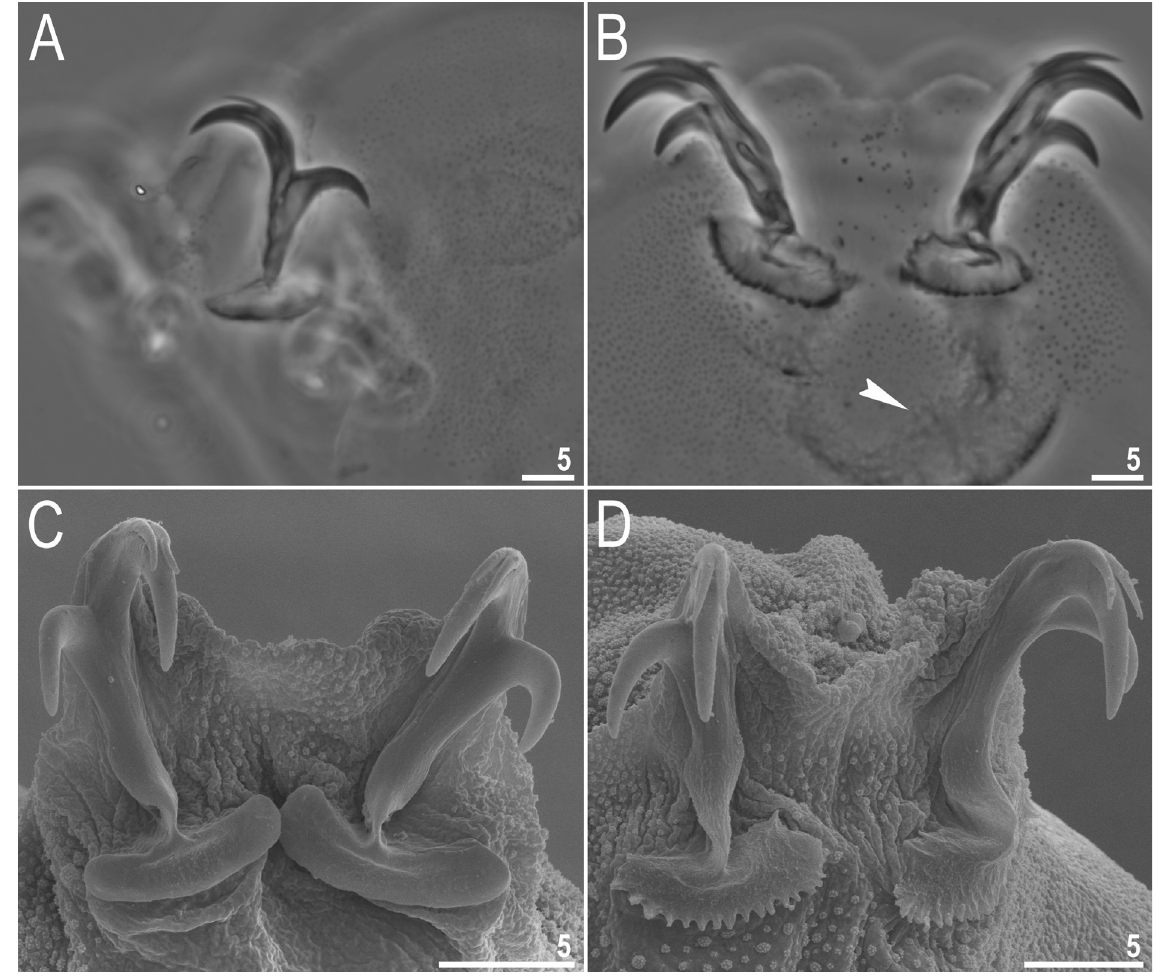
Fig. 14. Tenuibiotus zandrae sp. nov. Claws (paratypes). A – B . Claws II and IV seen in PCM, respectively. C – D . Claws I and IV seen in SEM, respectively. Filled indented arrowhead indicates horseshoe structure connecting the anterior and the posterior claw. Scale bars in